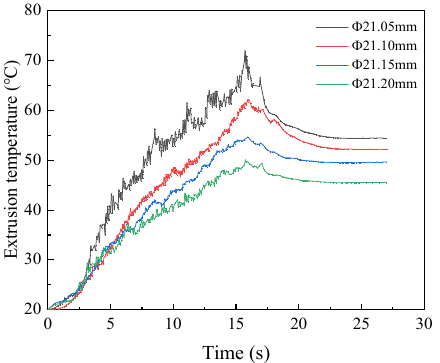
Figure 18. Influence of bottom hole diameter on